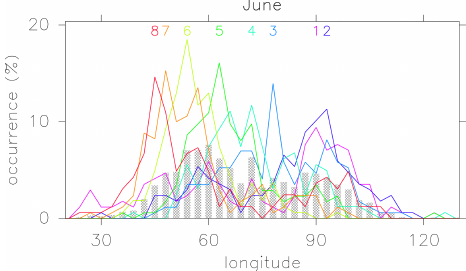
Figure 16. Longitudinal distribution of the occurrence frequency of the AMA center defined as the geopotential maximum at the 100hPa pressure level. Hatched bars show the total average. Lines show partial averages of the data assigned for each phase, as de- noted by numbers of the corresponding